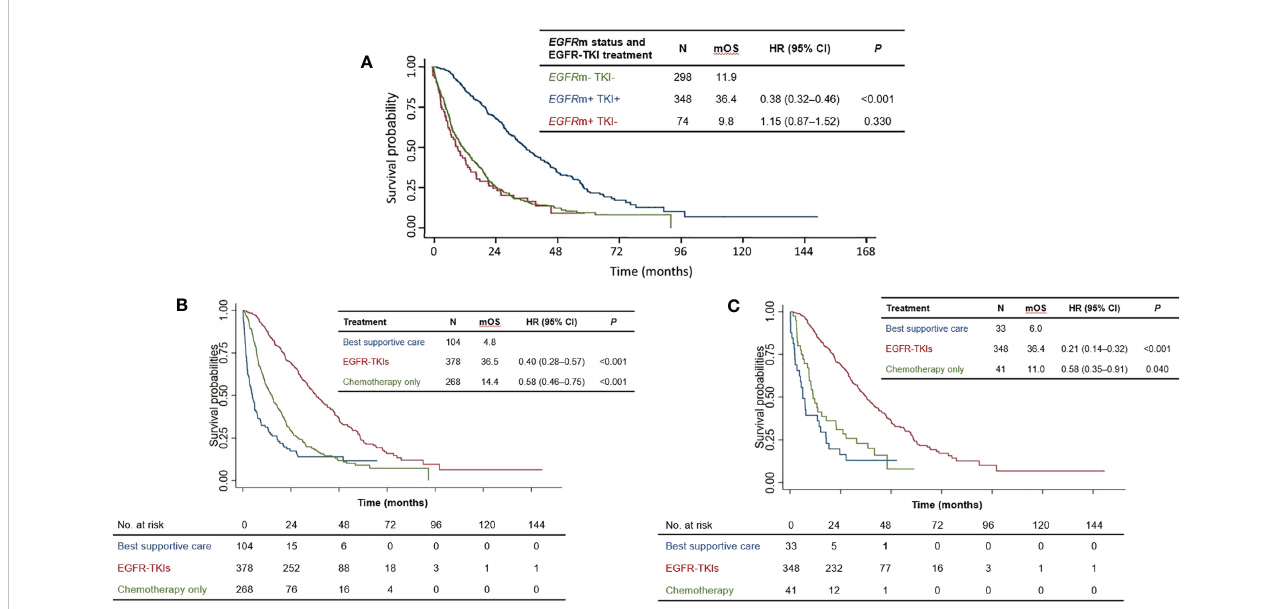
FIGURE 2 (A) Overall survival of patients according to EGFR m status and EGFR-TKI treatment. (B) Overall survival of patients according to treatment type for the total patient population. (C) Overall survival of patients according to treatment type for EGFR m-positive patients. mOS = median overall survival; HR, hazard ratio; CI, con fi dence interval; EGFR-TKI, Epidermal growth factor receptor-tyrosine kinase inhibitor; EGFR m+, positive for EGFR activating mutation, EGFR m − , wild-type